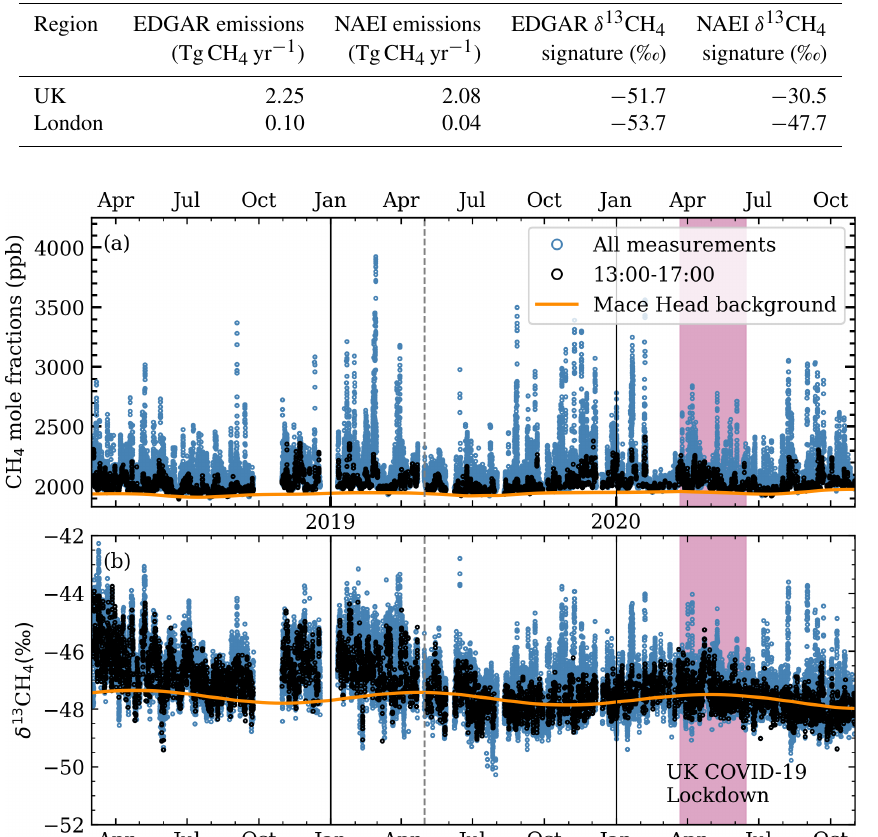
October–November–December (OND) averaged mole